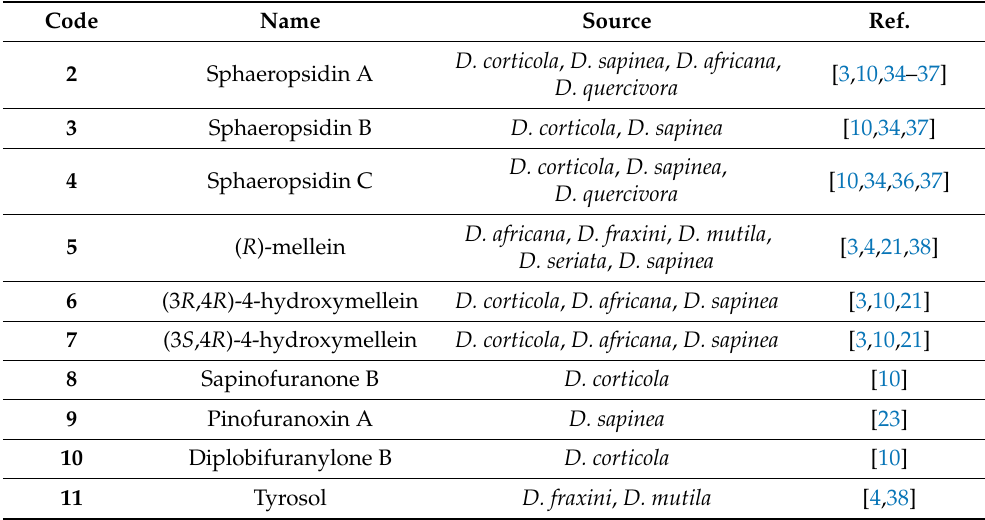
Table 2. Secondary metabolites identified in this work and previously reported as products of Diplodia